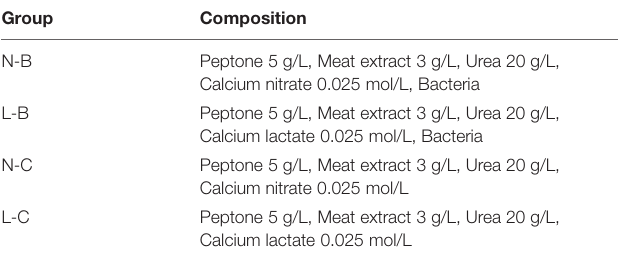
TABLE 1 | Composition of liquid medium for each group. Group Composition